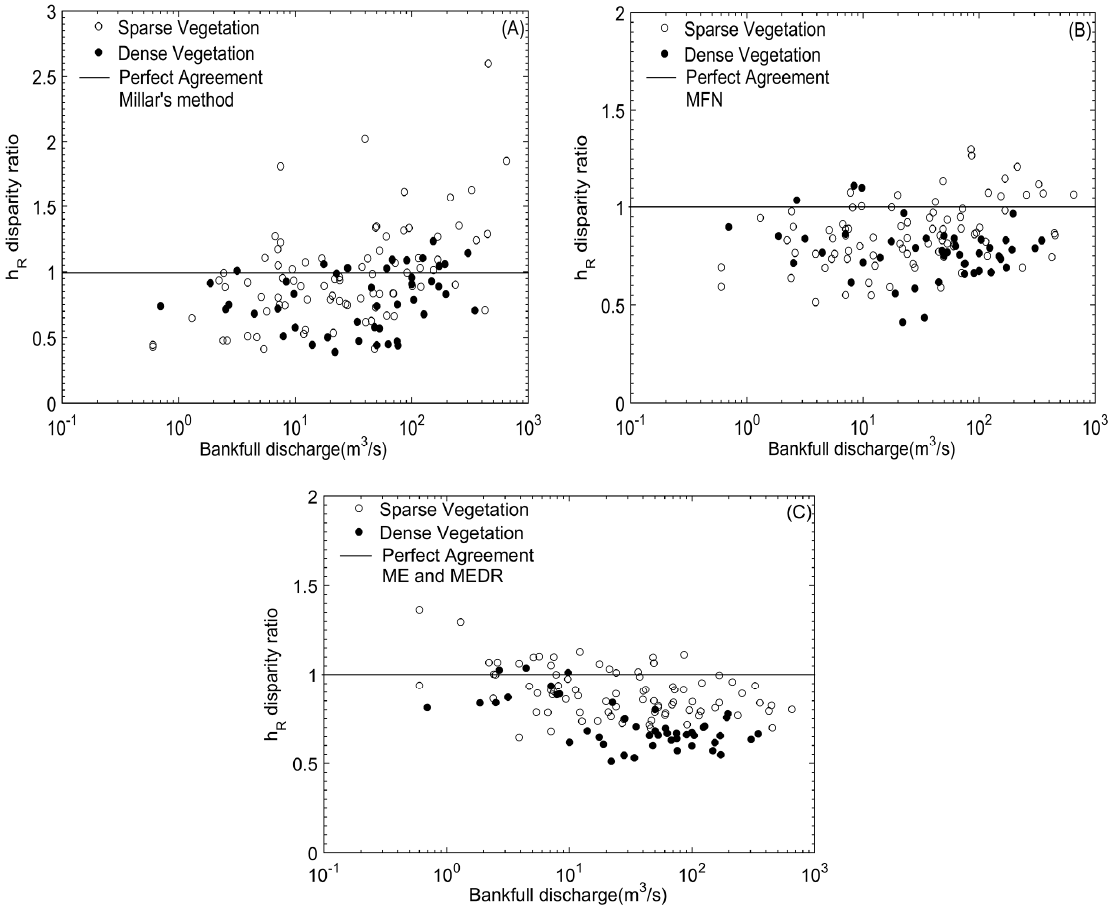
Figure 10. Scatter plot of disparity ratio h (cid:2902) against bankfull discharge for gravel bed